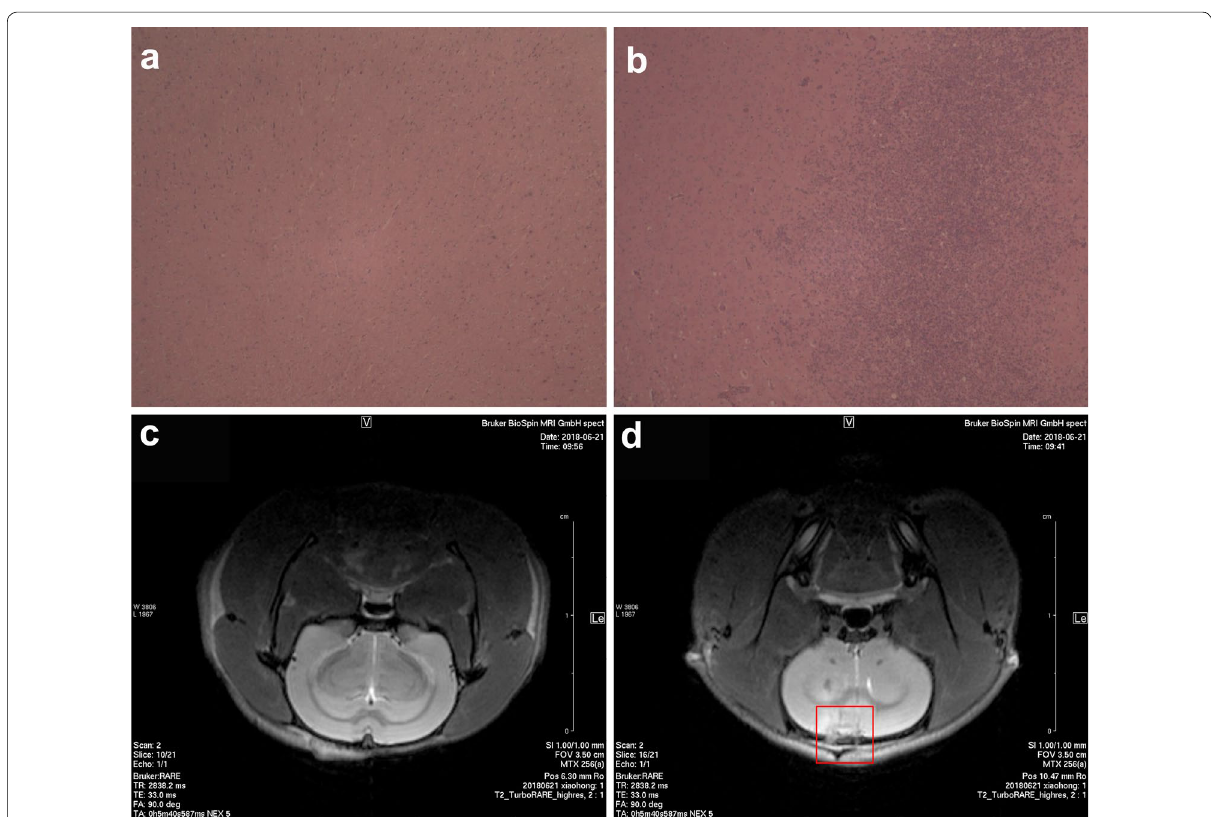
Fig. 5 scFab-ANG targets glioma cells in the C6 rat glioma in situ model. HE staining ( a , b ) and magnetic resonance imaging ( c , d ) were applied for assessing whether C6 glioma cells were successfully inoculated into Wistar rats. a and c represent the images of rats’ brains that were not inoculated with C6 glioma cells and b , d represent images of rats’ brains inoculated with C6 glioma cells. The rectangle in d represents the site of glioma cells inoculated in the